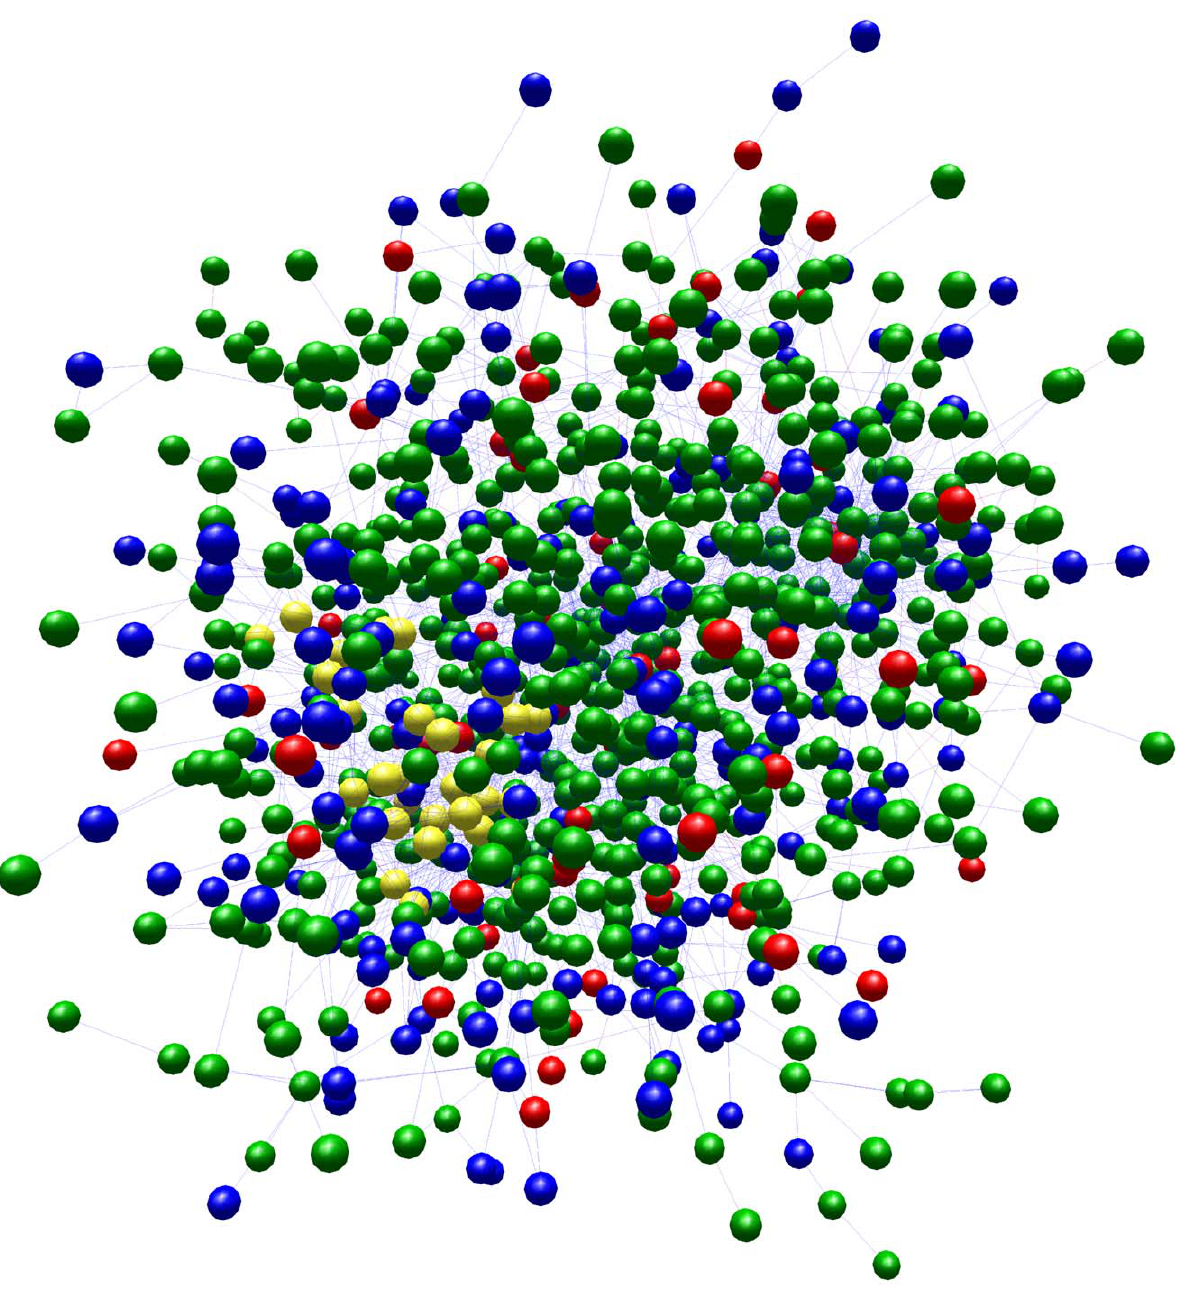
Figure 4. Variant surface glycoprotein (VSG) repertoire of T.b.brucei (927) represented as a three-dimensional network graph. 1258 T. b. brucei VSG protein sequences were compared using pairwise BLAST searches. BLAST scores were used to arrange VSG into a graph using BioLayout Express 3D 3.0. 968 individual VSG are represented as coloured spheres and are joined by edges to all other nodes with which they share . 70% amino acid identity. The program minimizes the distance required to arrange all nodes such that related nodes are arranged closest to one another. Nodes are shaded by type: orthologous sequence in T. b. gambiense (blue), orthologous sequence in T. b. gambiense , but closest relative in T. b. brucei (green), no corresponding sequence in T. b. gambiense (red), metacyclic-stage VSG (purple) and VSG-related (VR) proteins